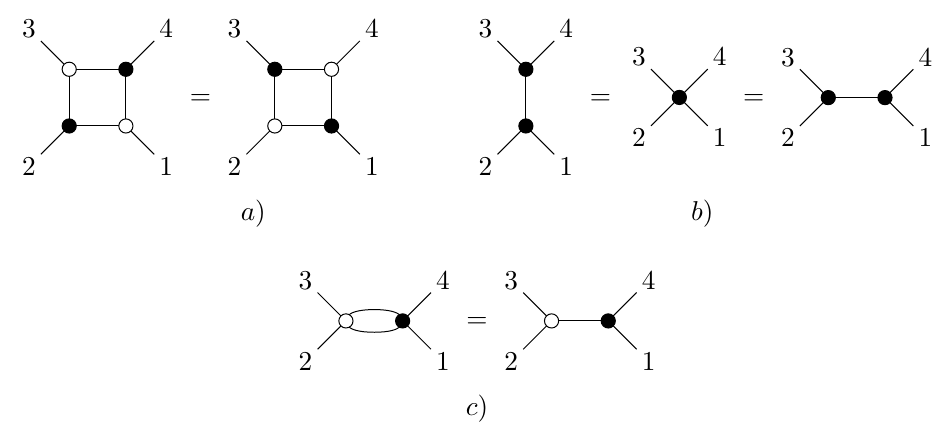
Figure 4 . Equivalence moves for on-shell diagrams: a) square move, b) merge/unmerge move for black nodes (similar for white nodes), c) bubble